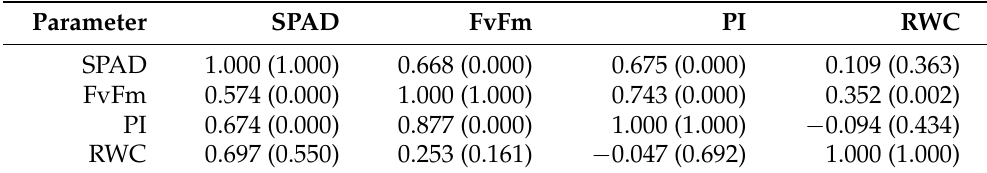
Table 3. Inter-parameter correlation between the measured ground-truth parameters (the Pearson’s correlation coefficient values are reported over the main diagonal, whereas the Spearman’s correlation coefficient values are given below the main diagonal; the corresponding p -values for the presented correlation coefficients are shown in brackets).